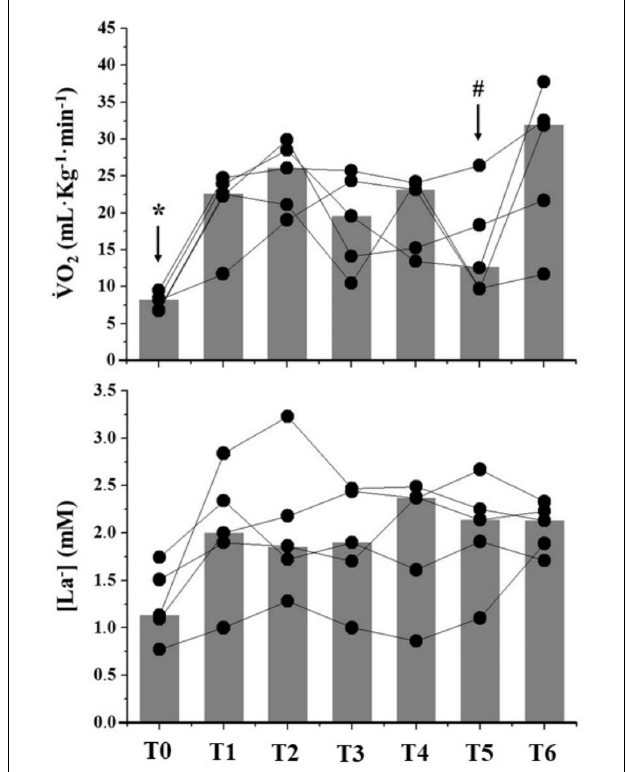
FIGURE 3 | Individual responses of physiological parameters observed at the measurement moments (T0–T6) throughout the simulated game. Gray bars represent median values at each moment of assessment. ∗ Significant differences from other measurement moments (T0 vs. T1–T6); # Significant differences from T6. ˙VO 2 , oxygen consumption; [La − ], blood lactate